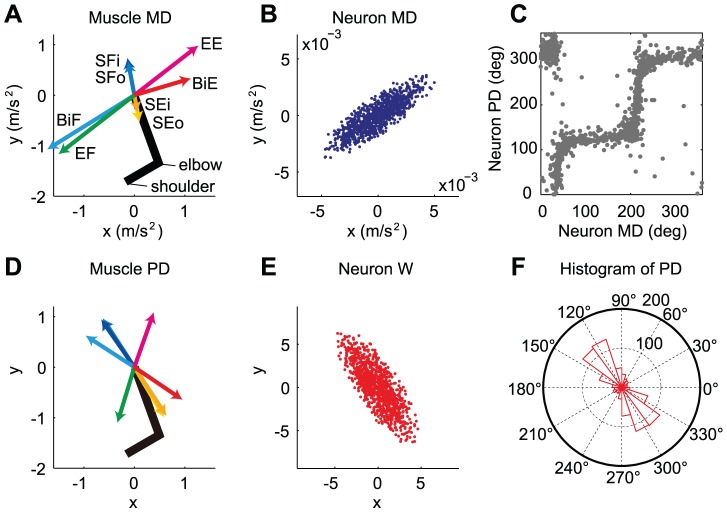
Simulation results for the 2D reaching movements.(A) MDVs for the 8 muscle groups. SFi, inner shoulder flexor (blue); SFo, outer shoulder flexor (light blue); SEi, inner shoulder extensor (orange); SEo, outer shoulder extensor (yellow); EF, elbow flexor (green); EE, elbow extensor (magenta); BiF, biarticular flexor (cyan); and BiE, biarticular extensor (red). (B) Distribution of the MDVs for 1000 neurons. (C) PDs plotted against MDs. (D) PDs of the 8 muscles after learning. (E) Distribution of the PDVs for 1000 neurons after learning. (F) Polar histogram of the neuronal PDs after learning.